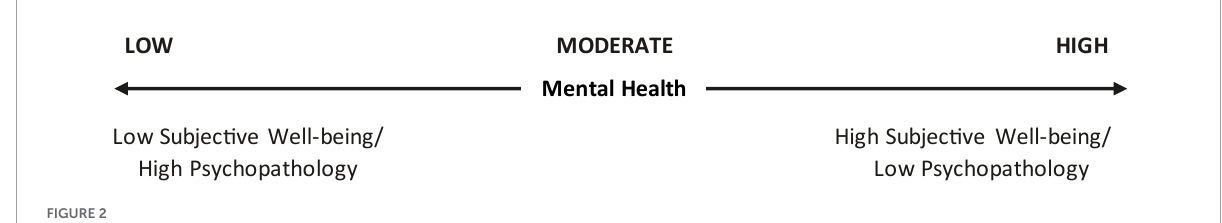
FIGURE2 Composite continuous measure of mental health inspired by the Dual-factor Model (Greenspoon and Saklofske, 2001; Wang et al., 2011). Psychopathology = sum of standardized internalized and externalized symptom scores; subjective well-being (SWB) = standardized negative